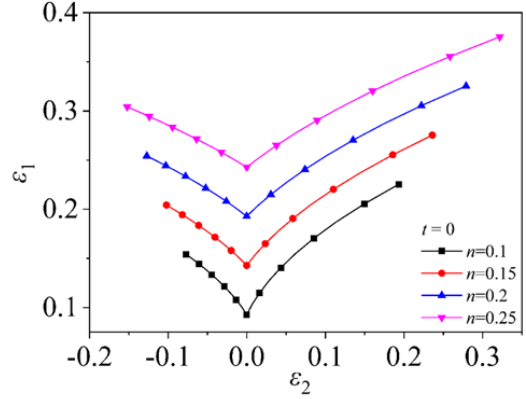
Figure 13. FLD for different values of n at t = 0.4.